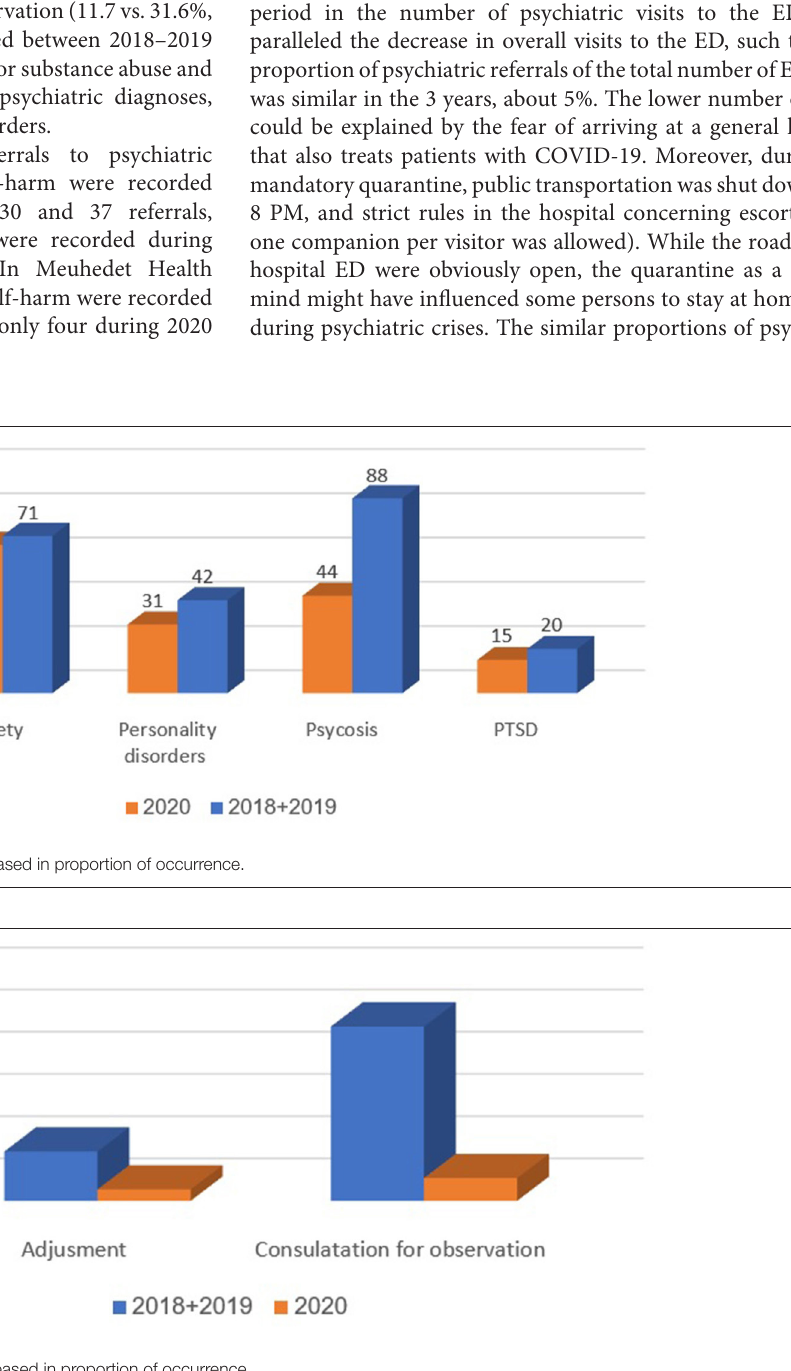
Frontiers in Psychiatry |